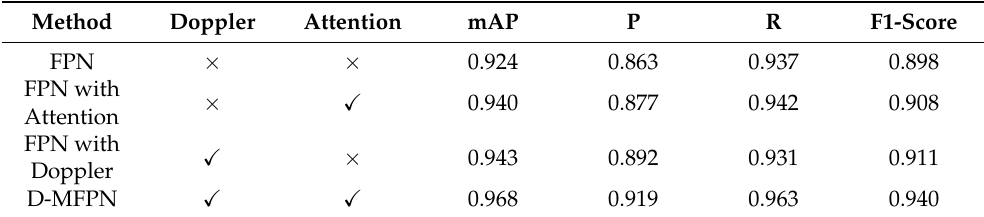
Table 1. The results of ablation studies.